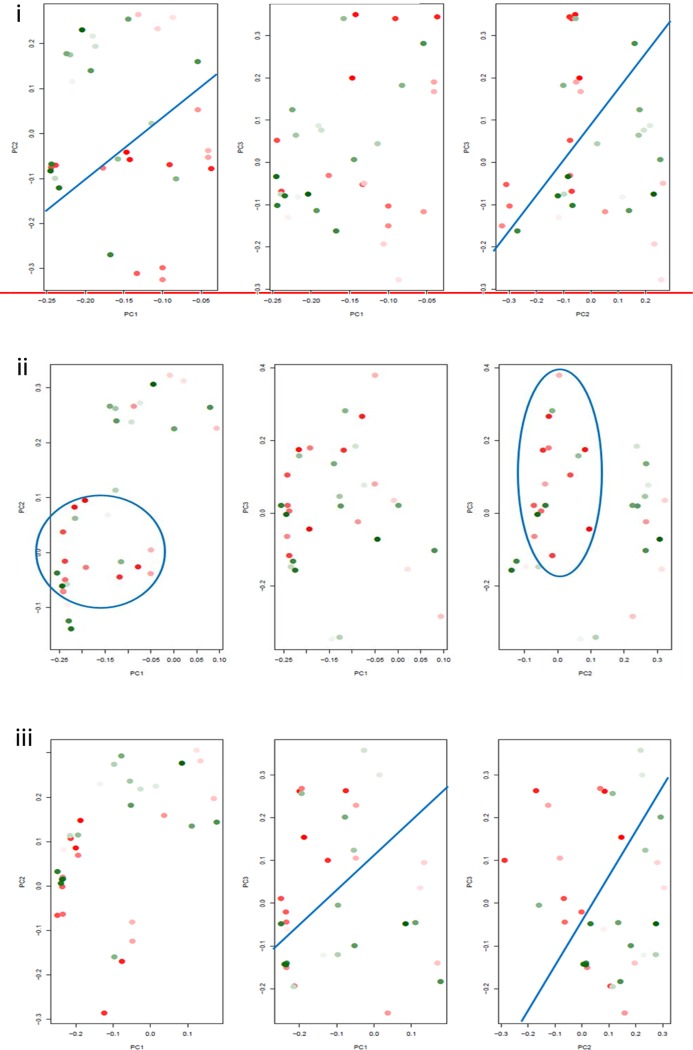
2D PCA plots showing clustering of high and low HIF-1α expressing GBM tertiles on the basis of differential expression of Notch pathway genes.Each data point in a plot denotes a GBM and depicts the score created by weighted summation of Notch genes’ expression in that tumor. The colour gradient from darkest red to darkest green denotes the highest HIF-1α expression to the lowest HIF-1α expression in the data points representing tumors. The demarcation between high HIF-1α GBM tertile and low HIF-1α GBM tertile in each plot has been displayed by using either lines or curves (blue coloured) which have been drawn manually to reveal the closely spaced cluster. Cluster formation was assessed by counting the number of the darkest red and the darkest green data points on both sides of the line; or those enclosed within the curve. GBM scores were created by the combination of either (i) all 15 Notch genes or (ii) 9 Notch genes (Notch1, Dll1, Dll4, Hes1, Hes2, Hes5, Hes6, Hey1, Hey2) and (iii) 7 Notch genes (Notch1, Dll1, Hes1, Hes2, Hes6, Hey1, Hey2) selected on the basis of HIF-1α heat map. HIF-1α-ordering of the tumors produced well-separated clusters of high and low tertiles based on 15 Notch genes’ as well as 7 Notch genes’ expression.